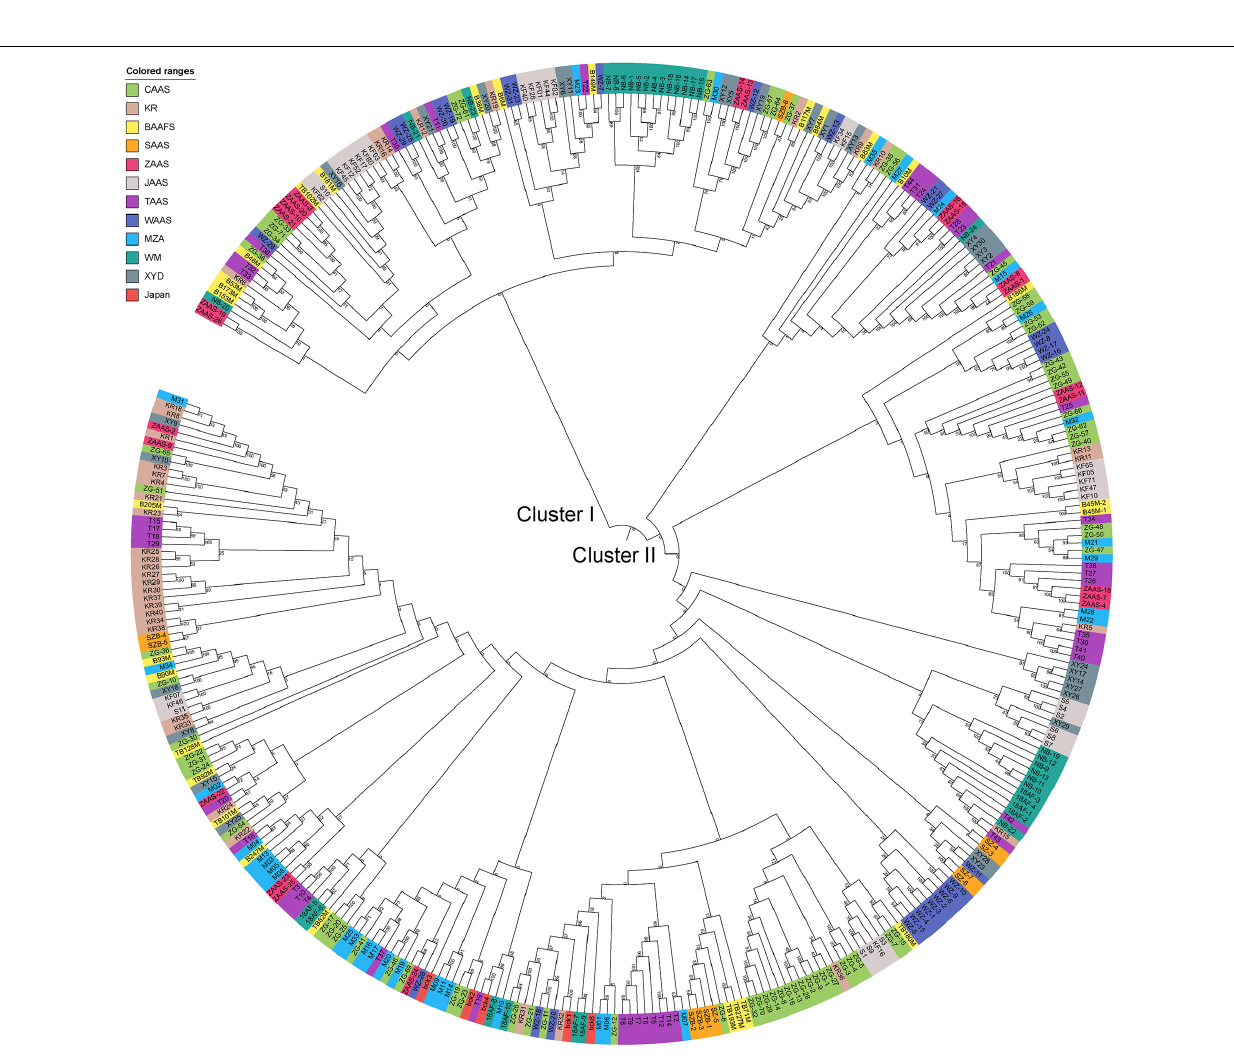
Frontiers in Plant Science |